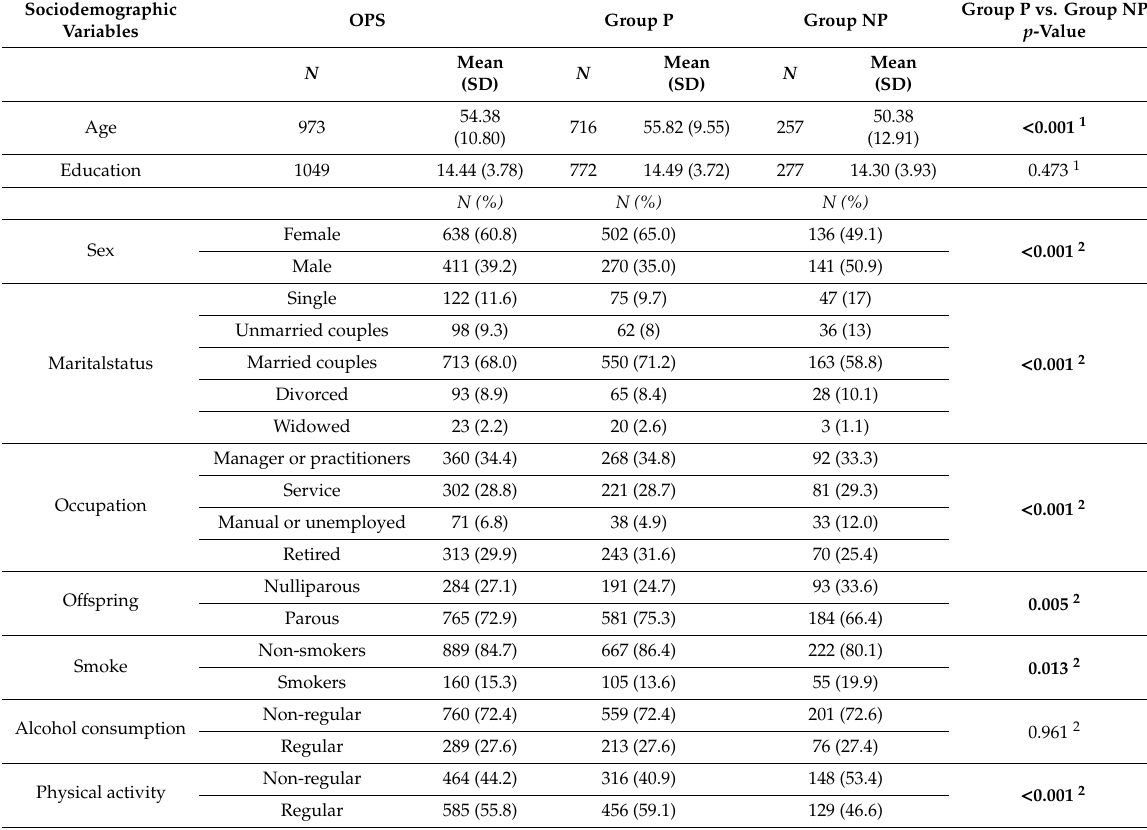
Table 1. Sociodemographic characteristics and primary prevention